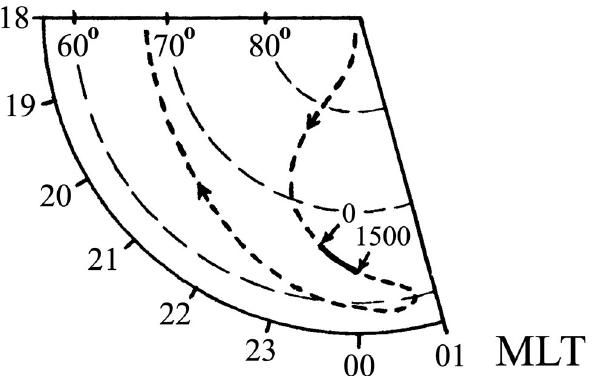
Fig. 1. The part of the convection trajectory around which the mag- netic field tube of plasma is carried in the numerical simulation un- der nocturnal conditions (dashed line). Arrows on the trajectory indicate the direction of the convection flow. The solid line marks the displacement of the plasma tube corresponding to the period of 1500s after turn-on of the HF